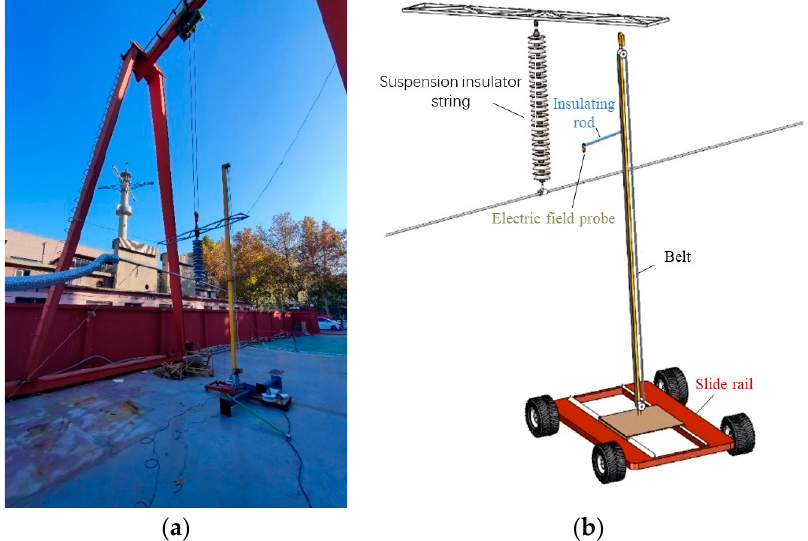
Figure 12. Test diagrams and schematic diagrams of sensitive insulators. ( a ) Test diagram of sensitive insulators. ( b ) Schematic diagram of detection device.